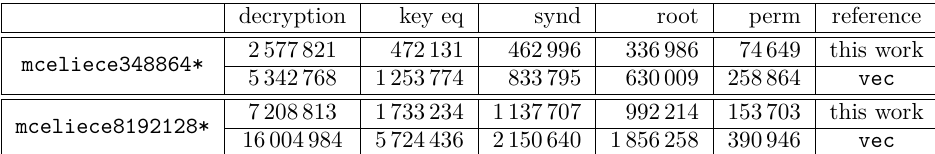
Table 9: Cycle counts for components in